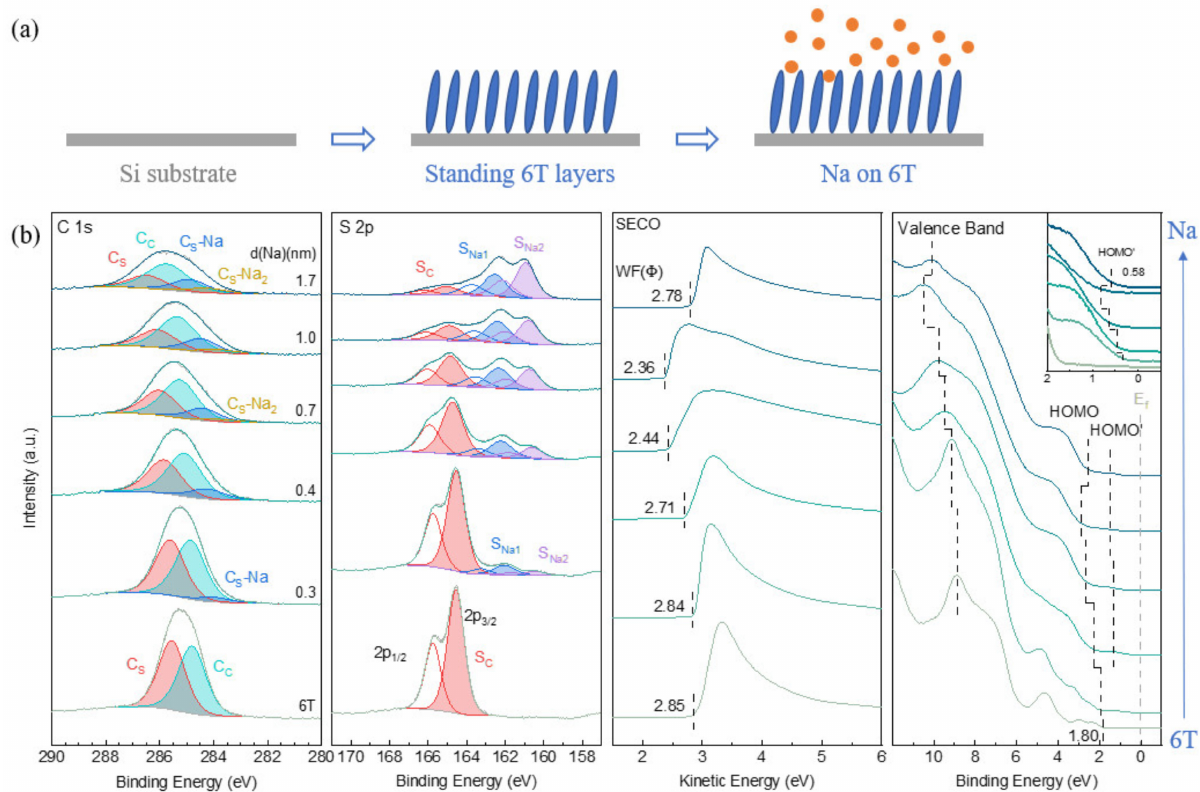
Figure 2. ( a ) Schematic of the 6T molecules and Na atoms deposition sequences. ( b ) XPS and UPS spectra of 6T films with stepwise Na deposition on a silicon